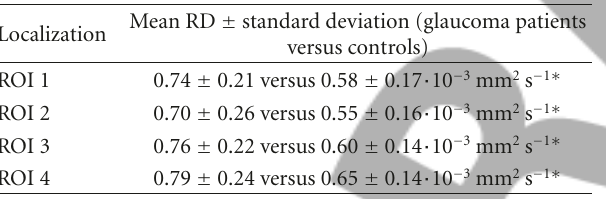
Table 1: Averaged RD values in di ff erent ROI of glaucoma patients and controls.